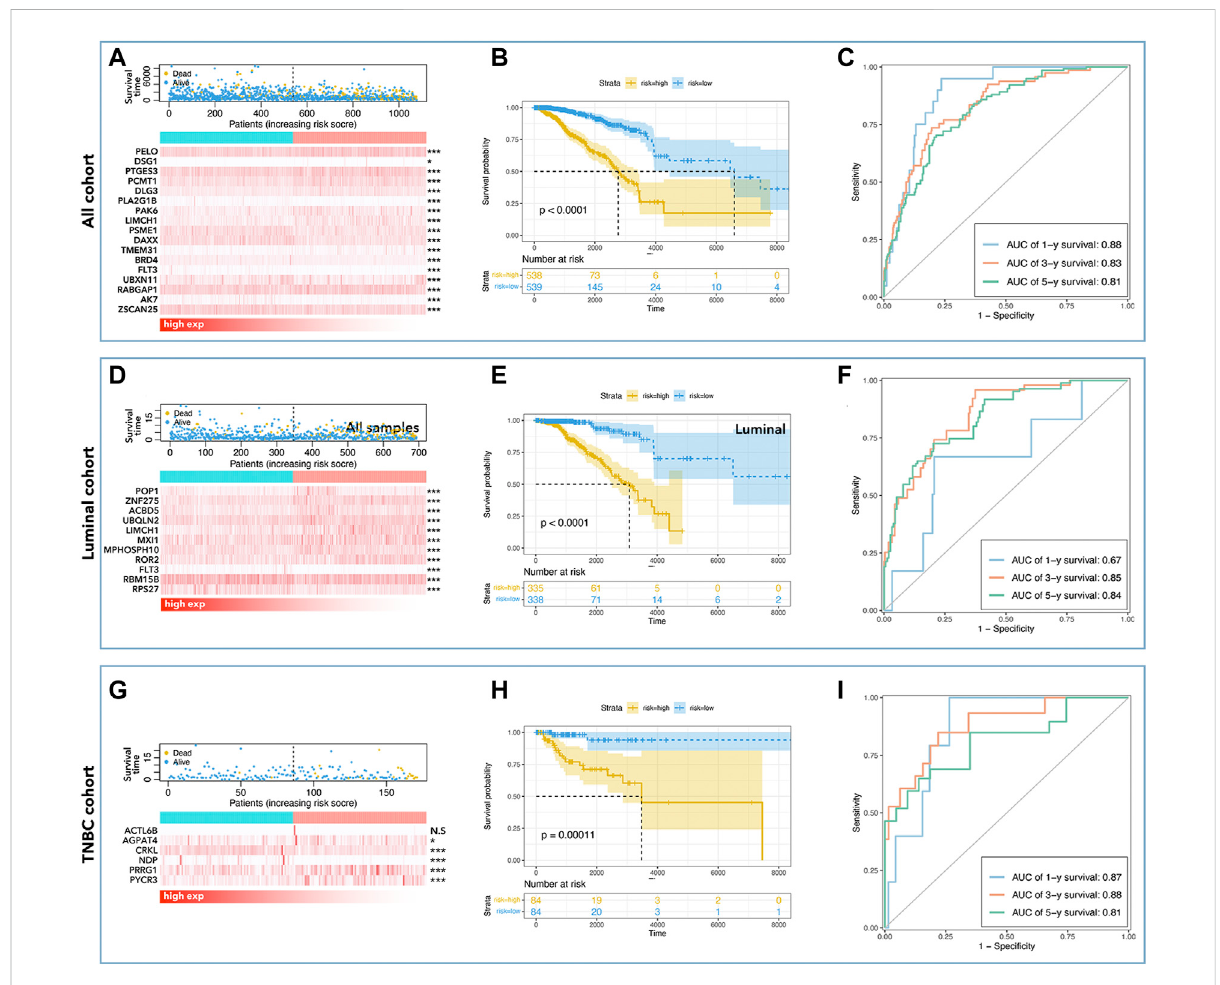
FIGURE 7 LLPS-relatedmulti-generisk-score.Risk-score-mortalityrelationshipandselectedLLPS-relatedgeneexpressiondifferencesareshownfor all cohort (A) , luminal cohort (D) , and TNBC cohort (G) . The K-M curve showed that low-risk had better prognosis in all cohorts (B) , the luminal cohort (E) , and in the TNBC cohort (H) . The AUC values of risk-score in all cohorts (C) were 0.88 (1 year), 0.83 (3 years), and 0.81 (5 years), in the luminal cohort (F) were 0.67 (1 year), 0.85 (3 years), and 0.84 (5 years), and in the TNBC cohort (I) were 0.87 (1 year), 0.88 (3 years), and 0.81 (5